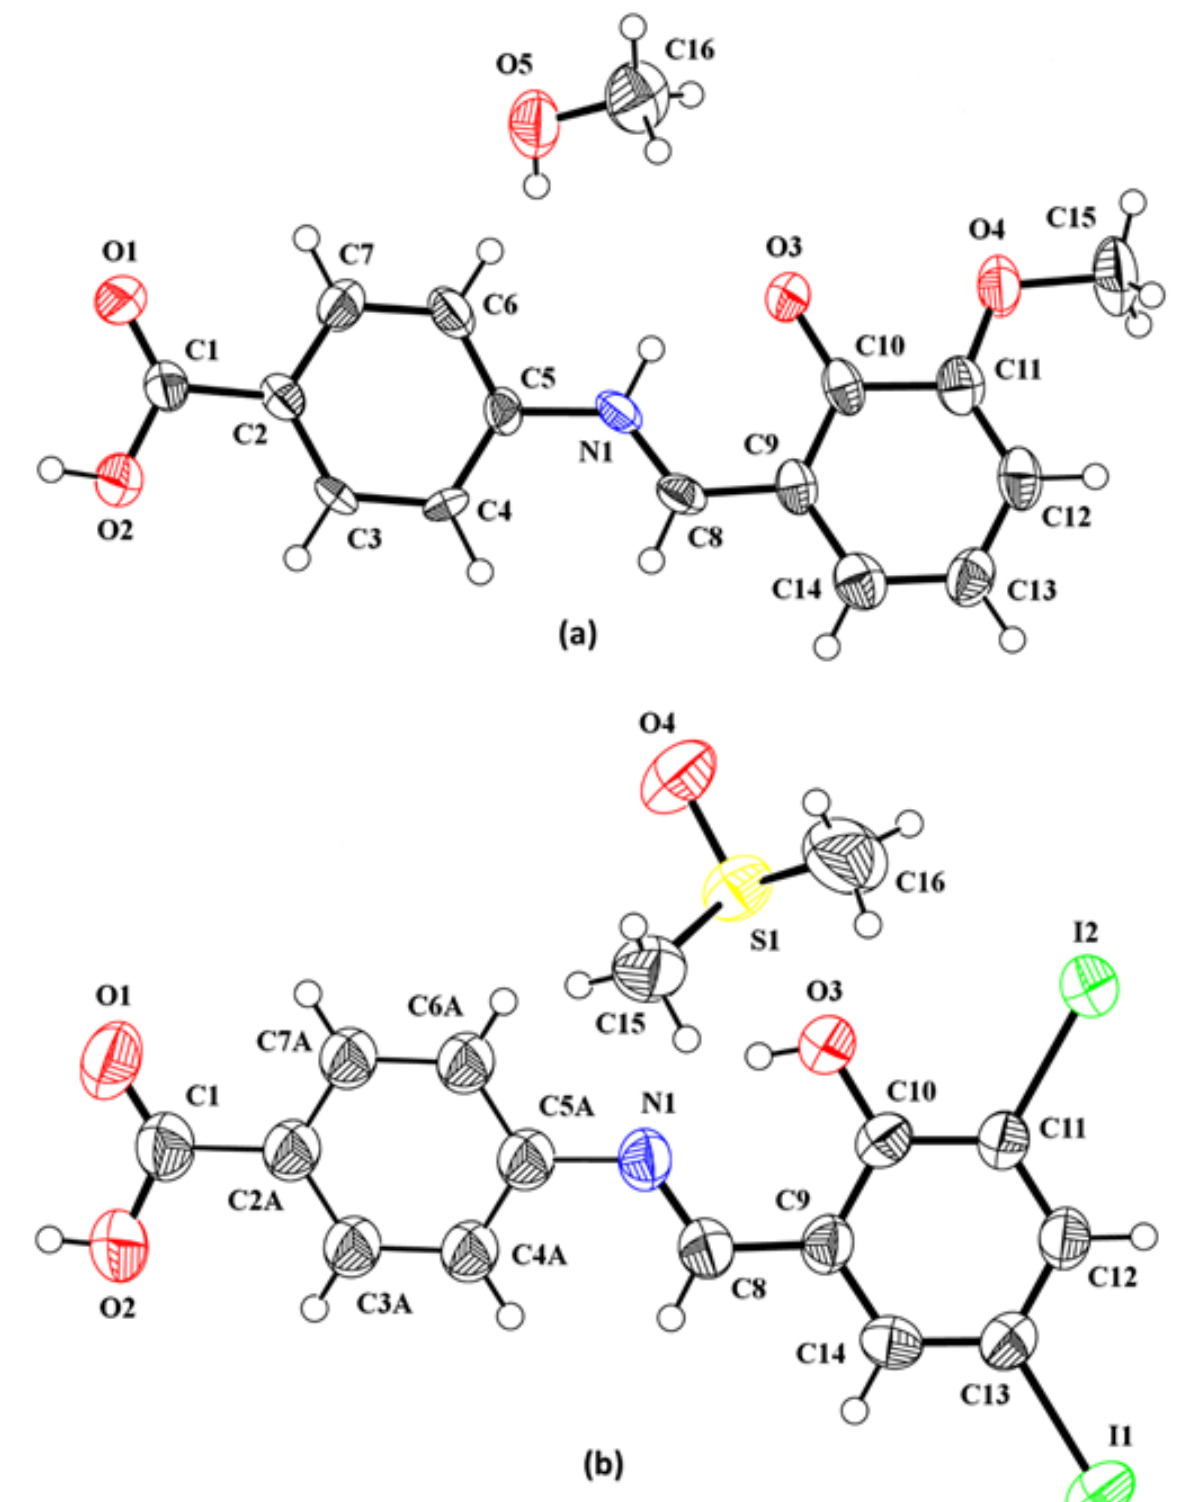
Figure 1. ORTEP diagram of ( a ) HMBA , ( b ) DHBA . Figures are portrayed at probability level of 50%. H-atoms are displayed by circles of arbitrary radii.